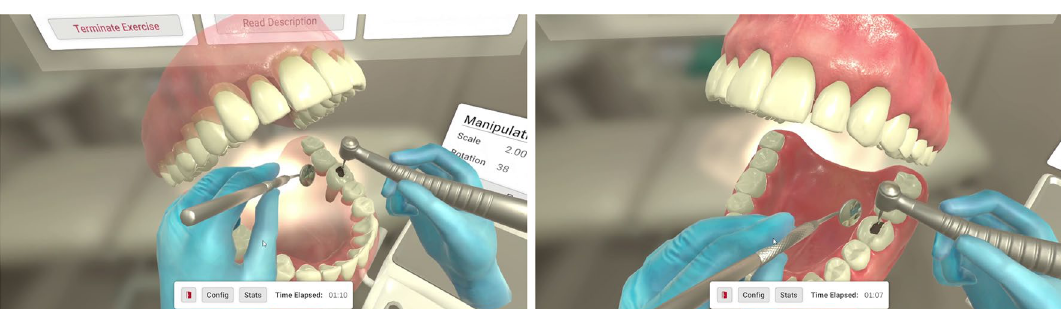
Figure 3. Different cavity types supported: on the left, a class 1 cavity, and on the right, a class 2 cavity. The denture model is scaled to double its original size and the drilling is executed with the help of a mirror for extra visibility. Additionally, the opacity of the Gums was turned down so the user could clearly see the root of the